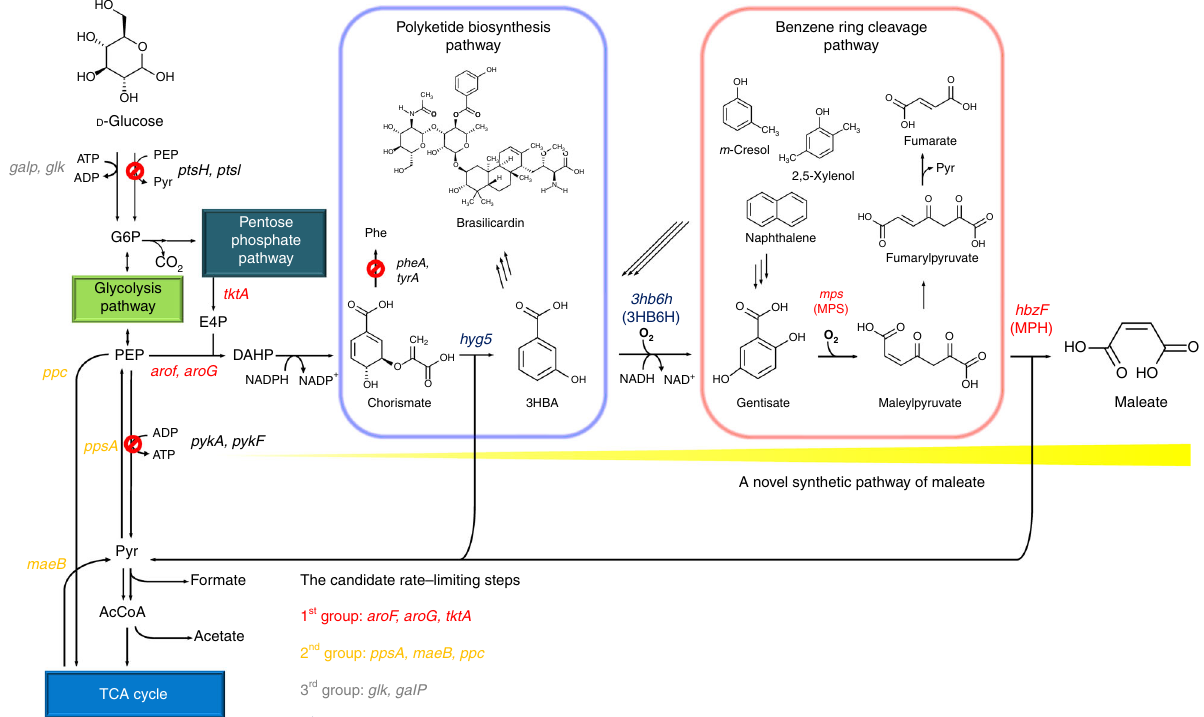
Fig. 1 The synthetic metabolic pathway for the production of maleate in E. coli . AcCoA acetyl coenzyme A, Cho chorismate, DAHP 3-deoxy-D- heptulosonate-7-phosphate, E4P erythrose-4-phosphate, G6P glucose-6-phosphate, 3HBA 3-hydroxybenzoate, (Iso)Cho isochorismate, Mal malate, NADP + oxidised NADP, Oxa oxaloacetate, PEP phosphoenolpyruvate, Phe L-phenylalanine, Pyr pyruvate NATURE COMMUNICATIONS | 8: